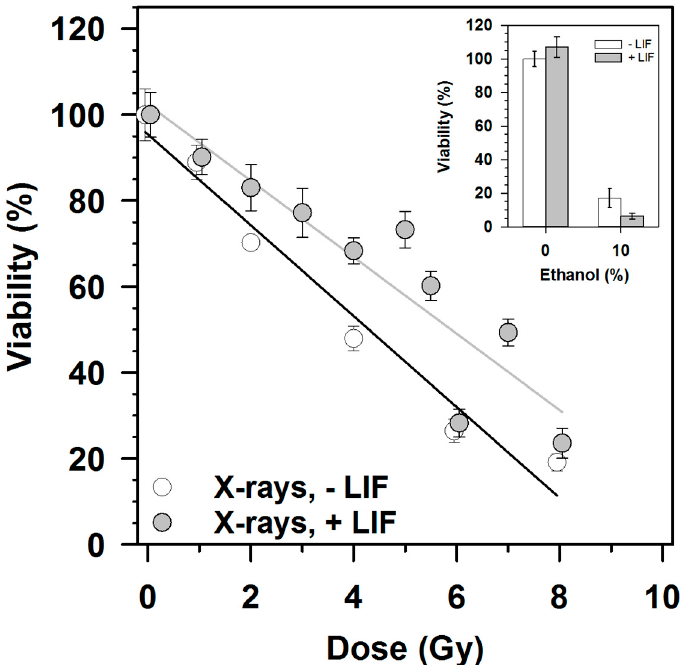
Figure 2. Viability after exposure of mESCs to 200 kV X-rays. Viability was determined by the MTT test. The cells were seeded, irradiated 24 h later and the MTT test was performed after 3 days incubation. Data of three independent experiments were combined; bars show the standard error of 12 wells (4 per independent experiment). The small inset shows the reduction of viability after cell incubation with 10% ethanol, as positive control for a cytotoxic effect, in the absence or presence of LIF. * p < 0.05 ( t -test) for 4 Gy, - LIF/+ LIF.